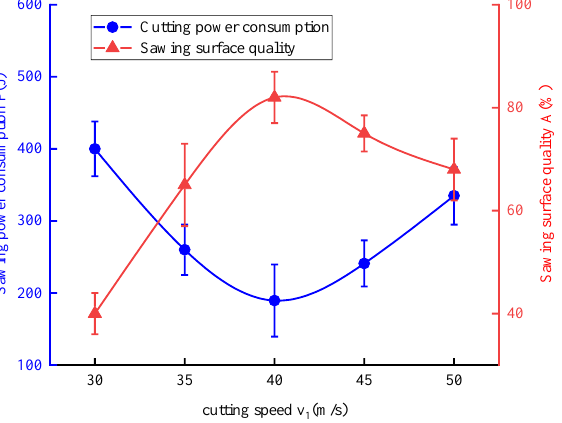
Figure 7. Sawing effect with different sawing speeds ( Note: Branch diameter 10~12 mm; feeding speed 0.35 m/s; cutting inclination 10°; number of teeth 80; moisture content 24.7~28.3% ).